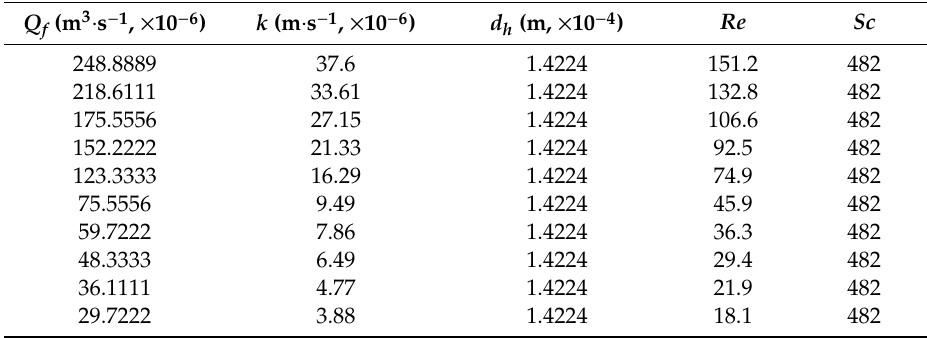
Table 3. Value of the mass transfer coe ffi cient ( k ) and Reynolds number ( Re ) under di ff erent Q